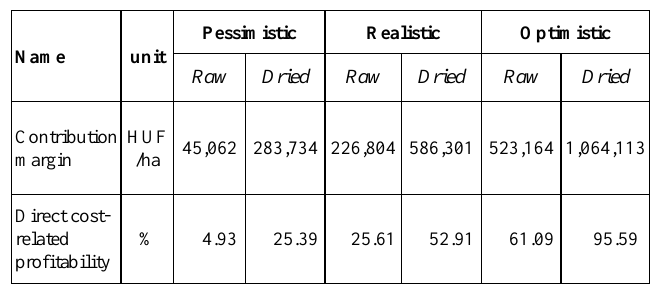
Table 8. Results of scenario analysis